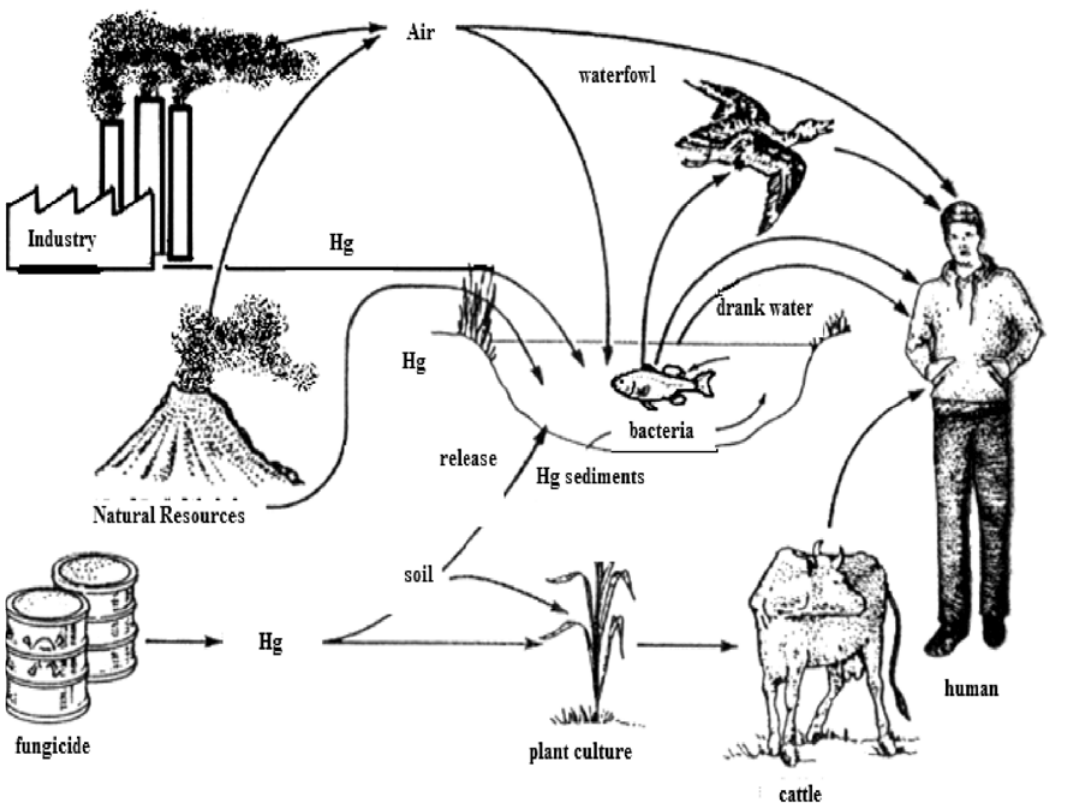
Fig. 1. Penetration of heavy metals into human organism through food